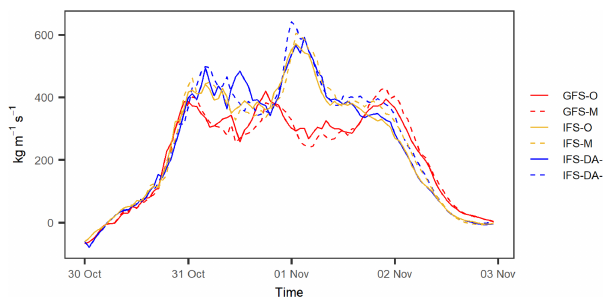
Figure 13. Time evolution of the vertically integrated water vapour flux (kgm − 1 s − 1 ) crossing section B–B’ (shown in Fig. 3b) from 00:00UTC on 30 October 2015 to 00:00UTC on 3 November